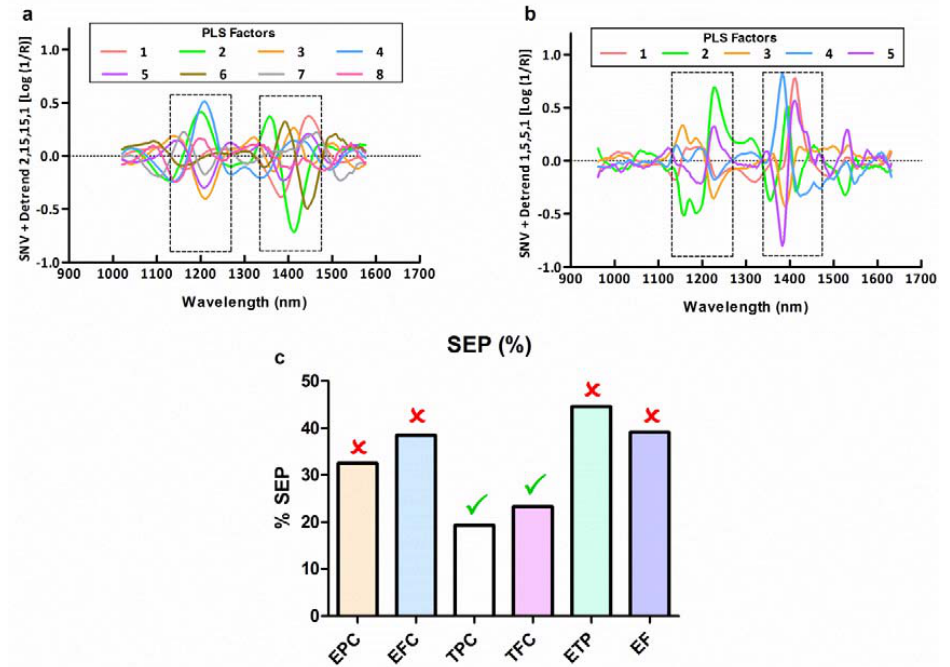
Figure 3. ( a ) Loading plots of the MPLS model for total phenolic content (TPC). ( b ) Loading plots of the MPLS model for total flavanolic content (TFC). ( c ) Standard errors of prediction obtained in the external validation procedure for all MPLS models carried out expressed as percentages.